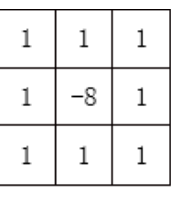
Figure 18. Gradient Laplacian convolutional kernel of the first convolutional kernel.